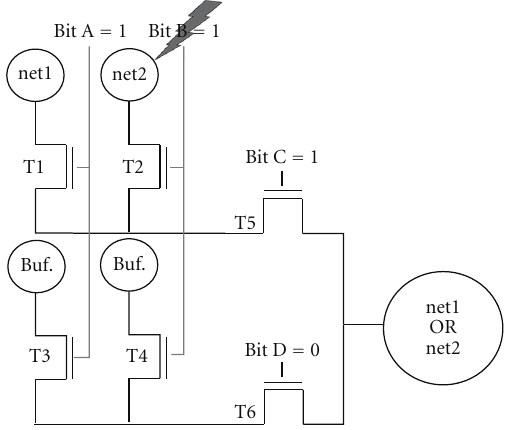
Figure 7: Example of a column bridging short. Bit B was a ff ected by an SEU.